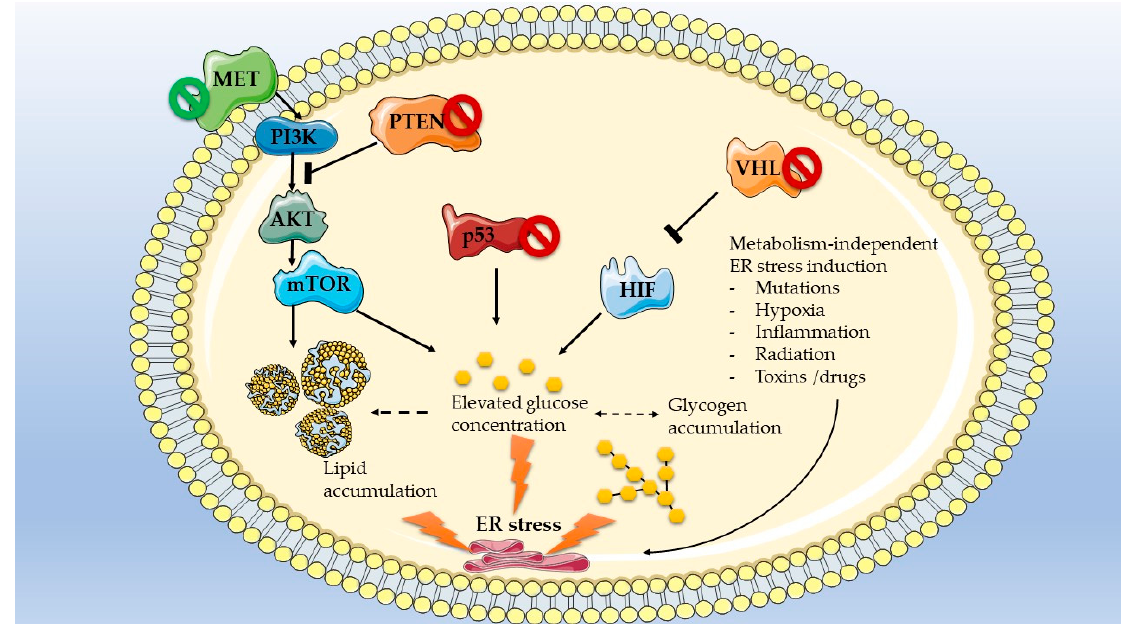
Figure 3. Frequent mutations in RCC and their impact on metabolism and metabolism-mediated ER stress activation. Tumor suppressors are represented in orange/red, pro-oncogenic factors are represented in green/blue. Proteins coded by frequently mutated genes are marked with the symbol Ø (green Ø indicates a mutation that increases gene expression/activity; red Ø indicates a loss of expression/activity). Graphical representation was designed using images from the Servier medical art database (smart.servier.com, accessed on 26 December 2022).